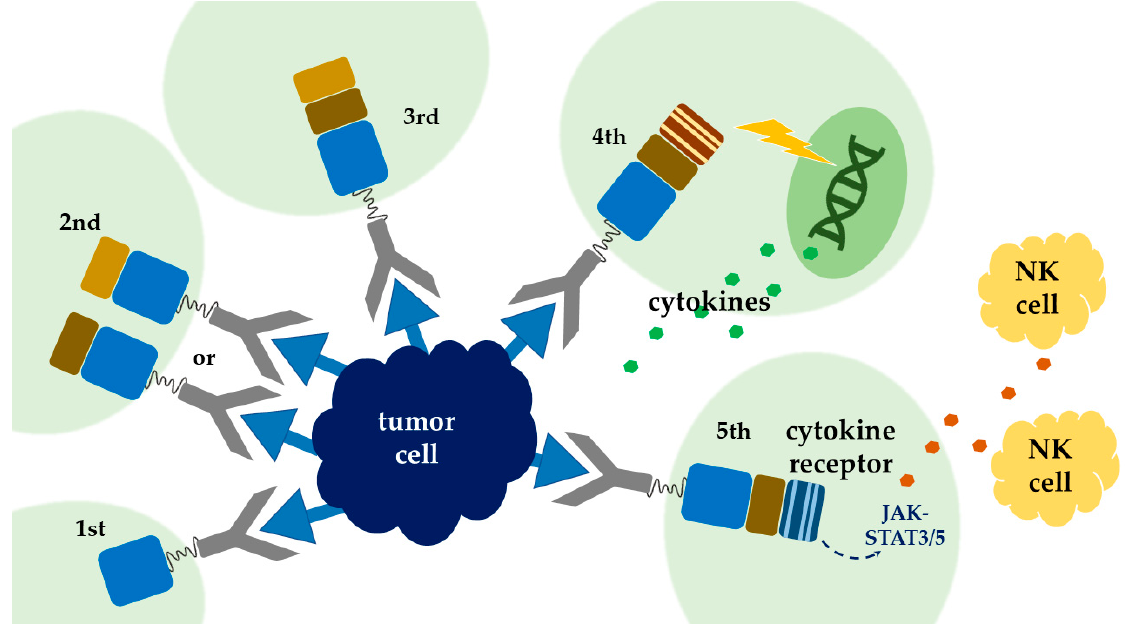
Figure 1. Five generations of chimeric antigen receptor (CAR) T-cell therapy. The blue cloudy shape in the middle symbolizes tumor cells with tumor antigens. The tumor is circled by five generations of CAR T cells. The five generations of CAR T-cell therapy are sequentially placed in clockwise direction. Gray Y type represents antigen-binding domains. The green shadow symbolizes intracellular space. The transmembrane domain serves as a bridge between the ectodomain and the endodomain. The first generation only contains CD3 ζ as an intracellular domain, which is the sky-blue box in the figure. CD28 or 4-1BB is then added, to generate the second generation. The third generation consists of both CD28 and 4-1BB motifs. Genes encoding cytokines including IL-12 or IL18 are tethered to the intracellular domain, to develop the fourth generation. The fifth generation comprises the IL-2 receptor and binding site for the transcription factor STAT3, in order to induce cytokine storm.